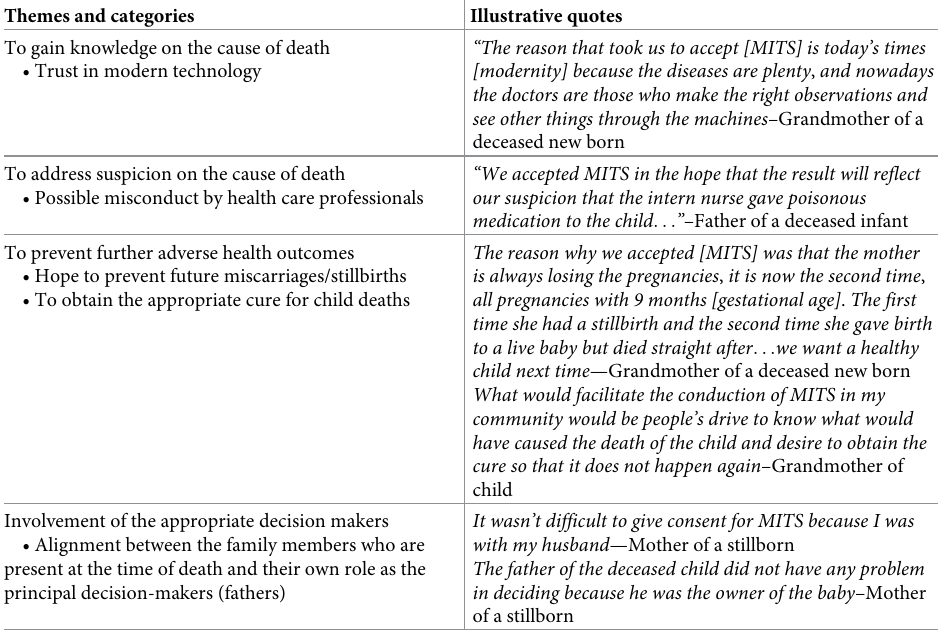
Table 5. Reasons for accepting a MITS as reported by parents/caretakers of deceased children (n =